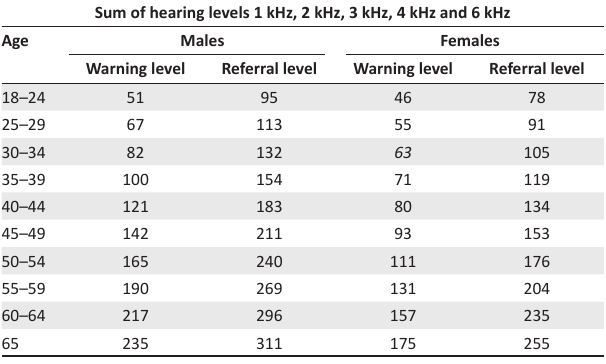
TABLE 2: UK Health and Safety Executive categorisation according to age